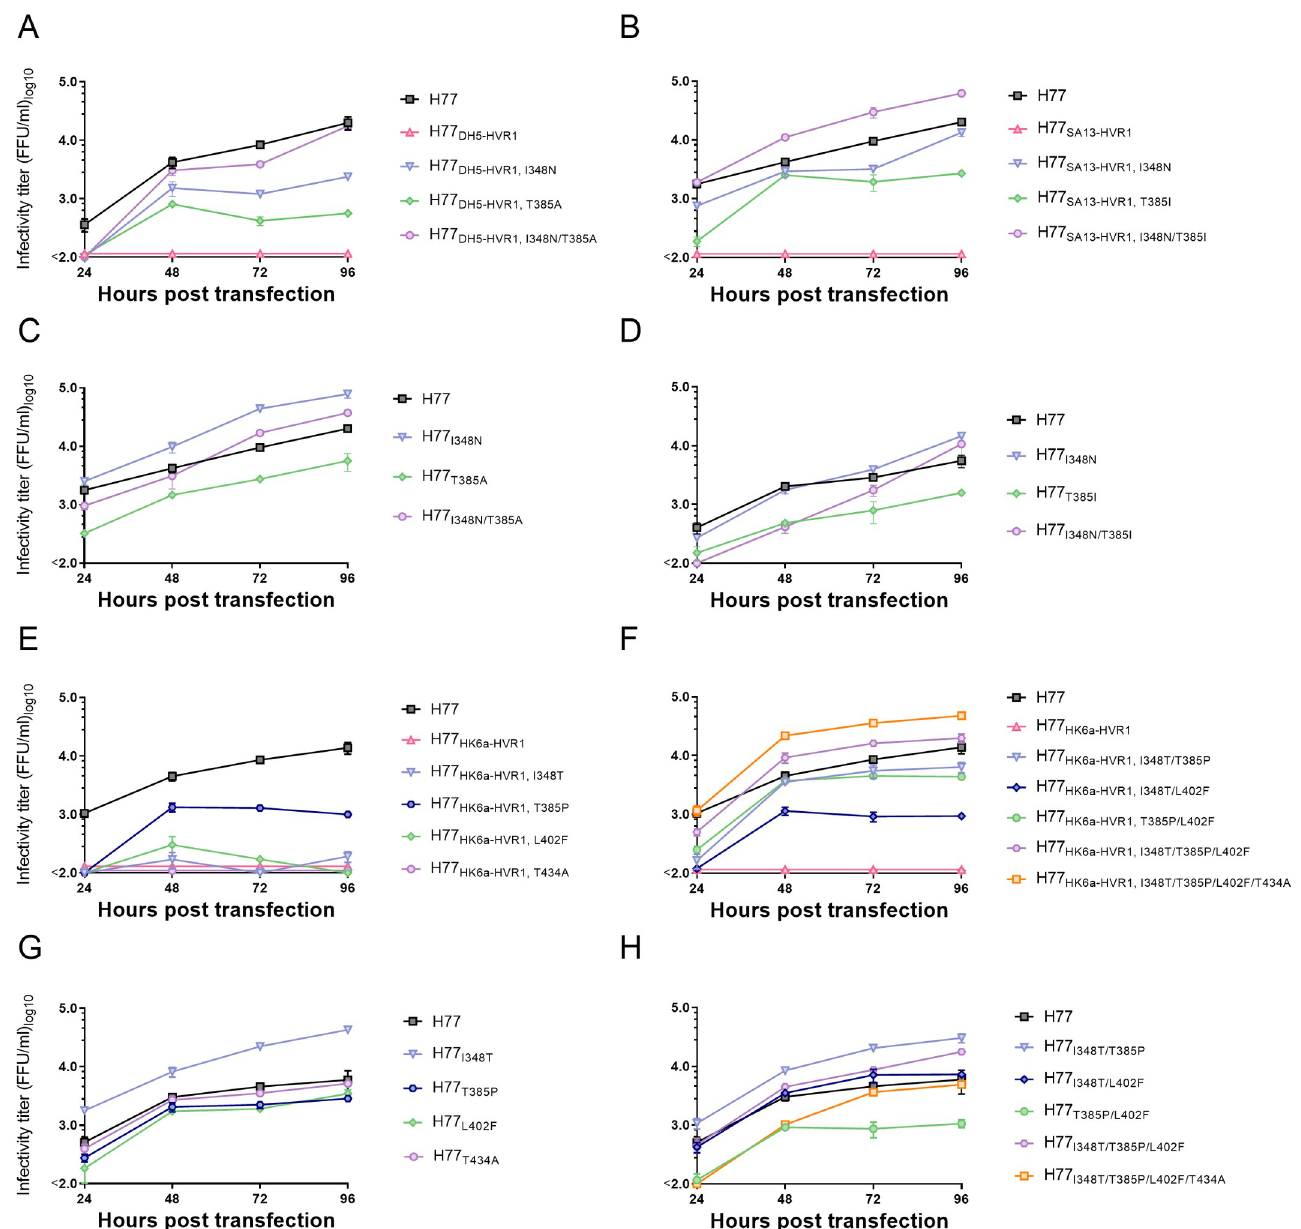
Fig 2. HVR1-swapped H77 recombinants require specific substitutions in E1 and HVR1 of E2 to restore infectivity. Huh7.5 cells were transfected with in vitro transcribed HCV RNA of the indicated recombinants. Supernatants were collected 24, 48, 72 and 96 hours post transfection, and HCV infectivity titers were determined. At each timepoint, infectivity titers are represented as a mean of three technical replicates. Error bars represent standard deviation. Lower level of quantification was 100 FFU/ml. The substitutions are numbered according to H77 abs. ref. (GenBank #AF009606). The data shown is a representative experiment out of at least